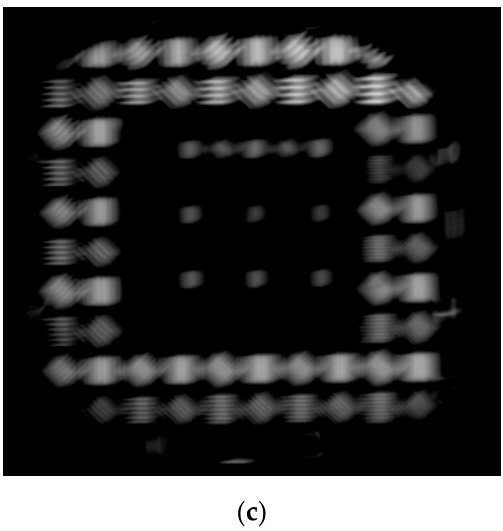
Figure 18. Visible light images obtained in dynamic imaging test in laboratory: ( a ) VHR = 0, V G = 0 ◦ /s; ( b ) VHR = 0.04, V G = 17.6 ◦ /s; ( c ) VHR = 0.04, V G = 17.6 ◦ /s and wrong IMC rates.